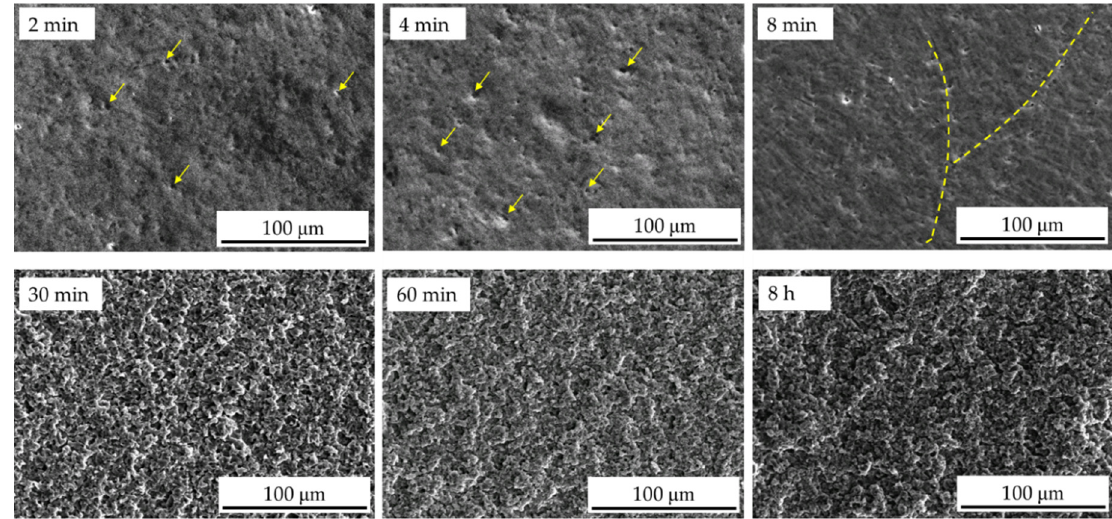
Figure 11. Morphological evolution of eroded surface for the studied alloy with increasing cavitation exposure time. The arrows indicate the pits, while the dashed lines show the boundaries of the melting pools.